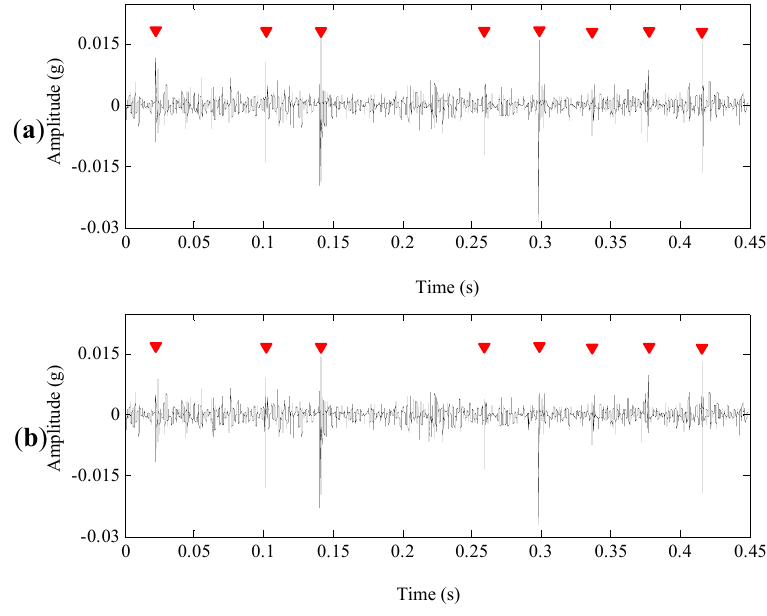
Figure 12. The denoising results of the normal planetary gearbox signal using GHM multiwavelet. ( a ) Improved neighboring coefficients. ( b ) Conventional neighboring